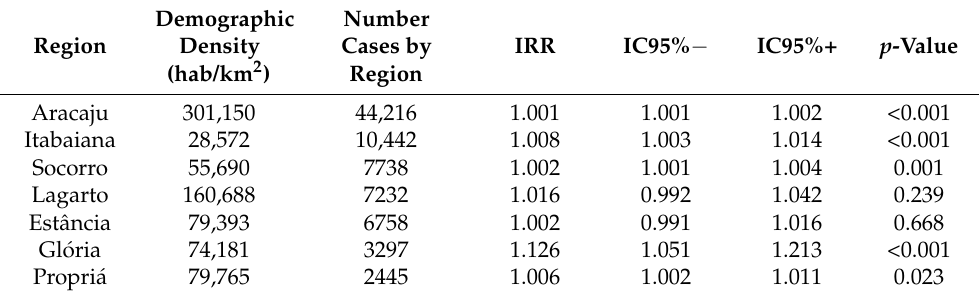
Table 1. Ratio of the incidence rate (RTI) between number of COVID-19 cases and demographic density of health regions—State of Sergipe. Period—April to October 2020.